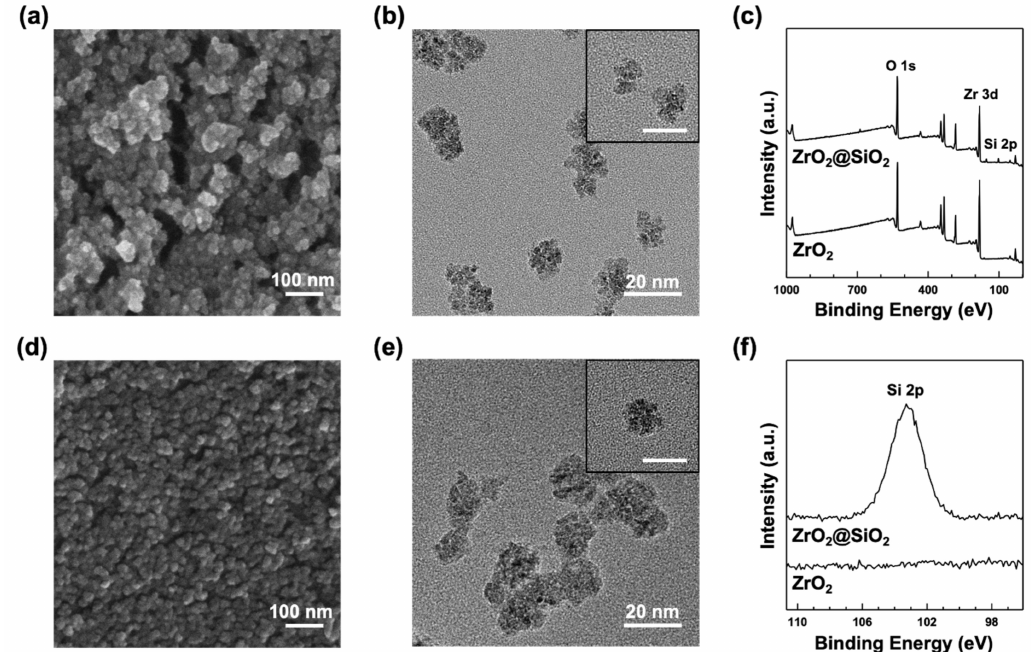
Figure 2. ( a ) SEM and ( b ) TEM images of synthesized ZrO 2 NPs. The inset shows a representative TEM image of an individual ZrO 2 NP with a 20 nm scale. ( d ) SEM and ( e ) TEM images of ZrO 2 @SiO 2 NPs. The inset shows a representative TEM image of an individual ZrO 2 @SiO 2 NP with a 20 nm scale. ( c ) Low-resolution XPS spectra of ZrO 2 and ZrO 2 @SiO 2 NPs. ( f ) High-resolution XPS spectra of Si 2p for both ZrO 2 and ZrO 2 @SiO 2